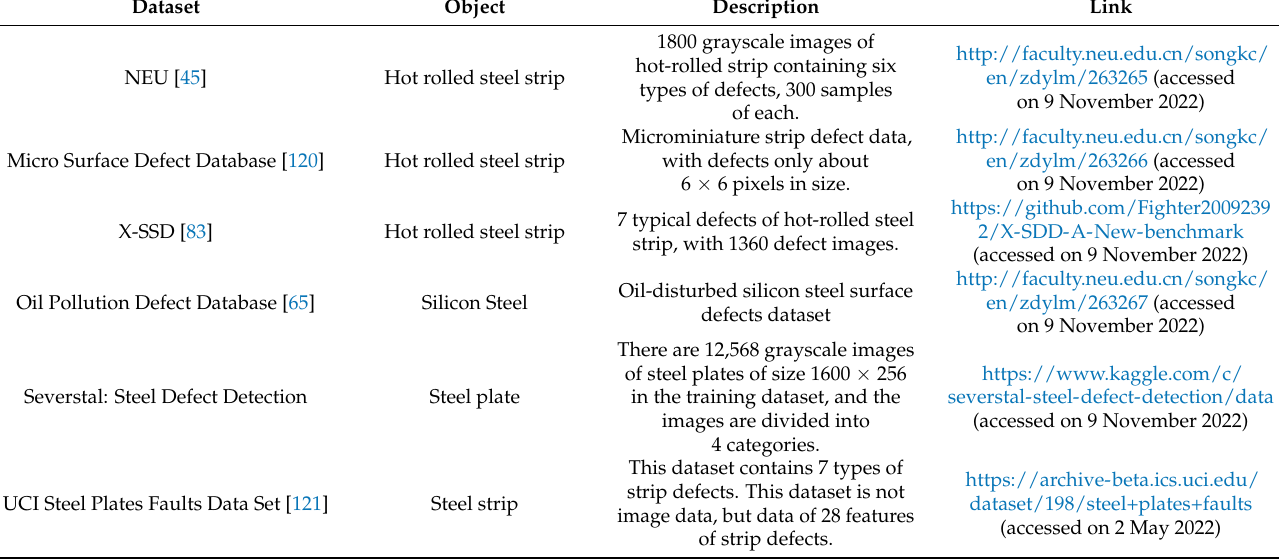
Table 6. Summary of the